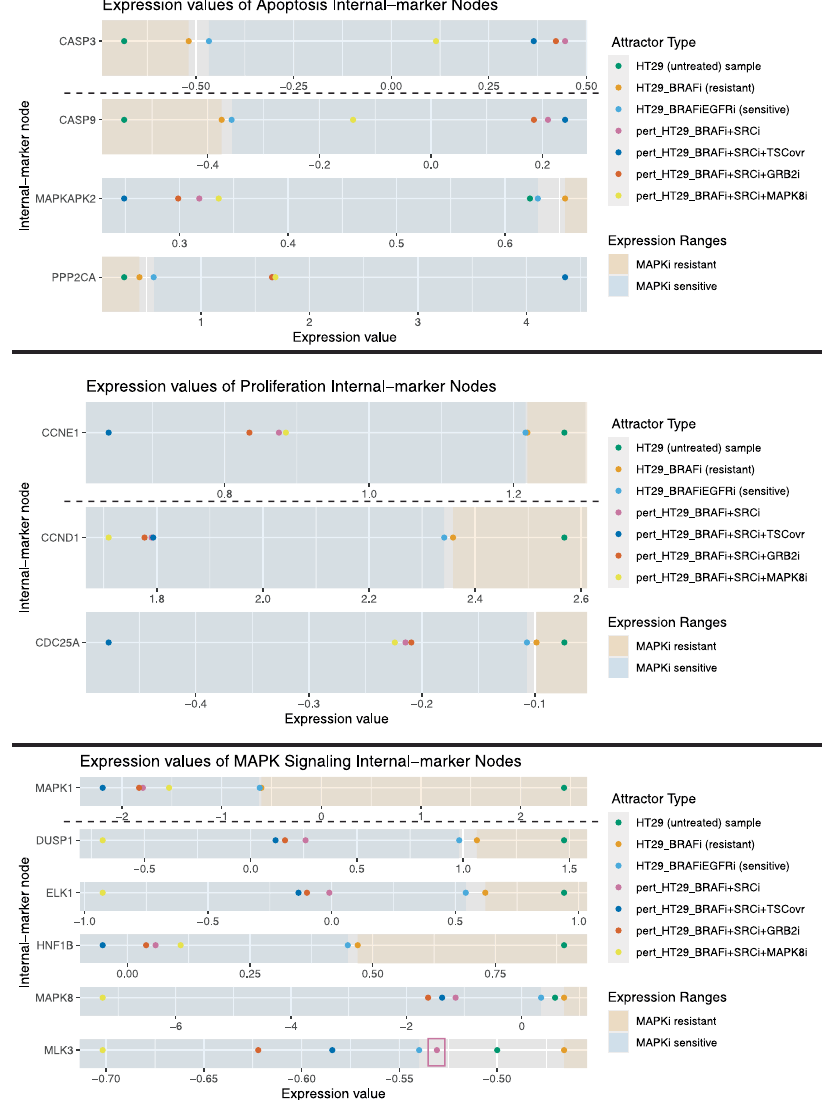
Fig. 8 Results of simulations of perturbations on FVS control nodes for overcoming adaptive resistance in colorectal cancer. Plots of internal-marker nodes ’ expression values at the attractors reached from the perturbations on FVS control nodes in HT29 cells in the colorectal cancer signaling network. The thirteen internal-marker nodes are divided by their associated phenotype — apoptosis (top), proliferation (middle), and MAPK signaling (bottom). Each plot contains, for one internal-marker node, the expression values at the attractors reached from the HT29_untreated, the HT29_BRAFi (MAPKi therapy-resistant), and the HT29_BRAFi + EGFRi (MAPKi therapy-sensitive), and the speci fi ed perturbations on FVS control nodes (HT29_BRAFi + SRCi, HT29_BRAFi + SRCi_TSC1ovr, HT29_BRAFi + SRCi + GRB2i, and HT29_BRAFi + SRCi + MAPK8i) initial conditions. Shaded regions of the plots indicate the MAPKi therapy-sensitive (blue) or MAPKi therapy-resistant (gold) samples expression ranges. In each panel, plots above the dotted lines are the original internal-marker nodes used by Park et al. Plots below the dotted lines are the additional internal-marker nodes. A perturbation is considered successful if 90% of the internal-marker nodes ’ expression values are within the expression ranges of the HT29_BRAFi + EGFRi-associated attractor (within the blue-shaded regions on the plots). We note that while the attractor state expression values of CCNE1 and MAPK1 are very similar, the difference between the values in the HT29_BRAFi + EGFRi- associated and HT29_BRAFi-associated attractors are in agreement with prior literature fi ndings. The four attractors generated by the speci fi ed combinations of perturbations on FVS control nodes pass the second fi ltering criterion when using only three internal-marker nodes from Park et al., CASP3, CCNE1, and MAPK1. However, the attractor generated by Park and colleagues ’ s perturbation of BRAFi + SRCi does not pass the second fi ltering criterion when considering the expanded set of internal-marker nodes, as the value of MLK3 is not within the MAPKi therapy-sensitive expression range (bottom panel, pink